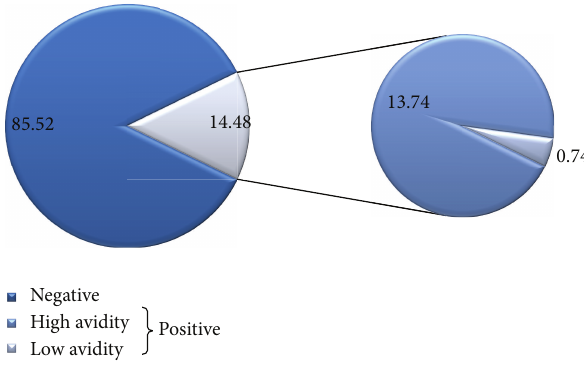
Figure 2: HSV-2 seroprevalence and avidity level among puerperal and pregnant women from Morelos,